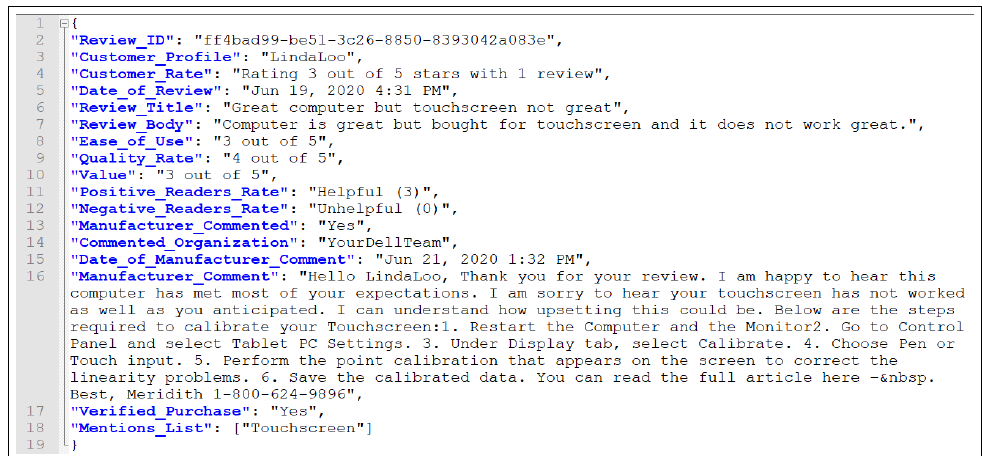
Figure 3. Sample of the original review data.